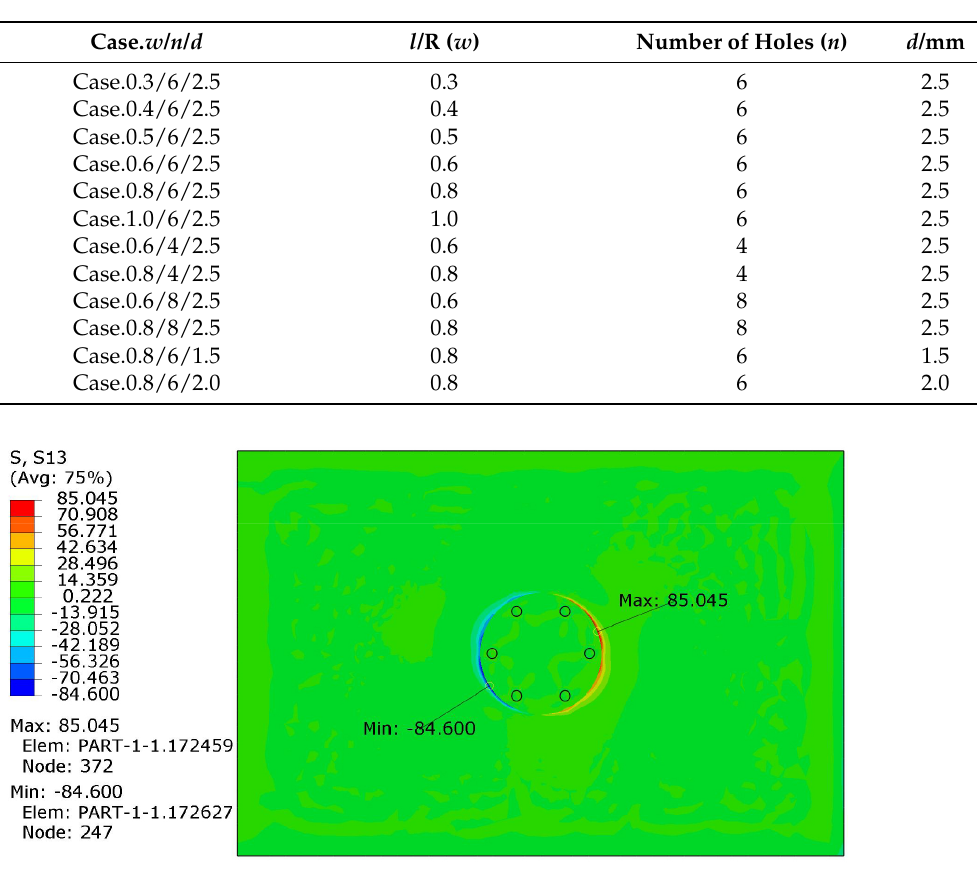
Table 2. Research cases in FEM.